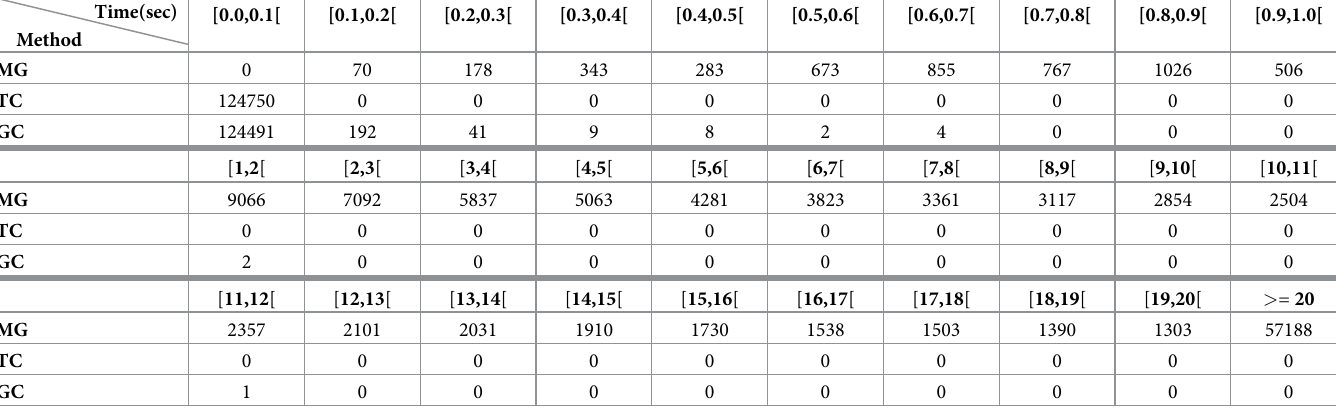
Note that for MG, 45.48% pairs of molecules were not computed because they were exceeding the maximum time allowed (20 seconds). Recall that for GC and TC we do not consider here the pre-processing time to compute graphs of cycles and fingerprints.